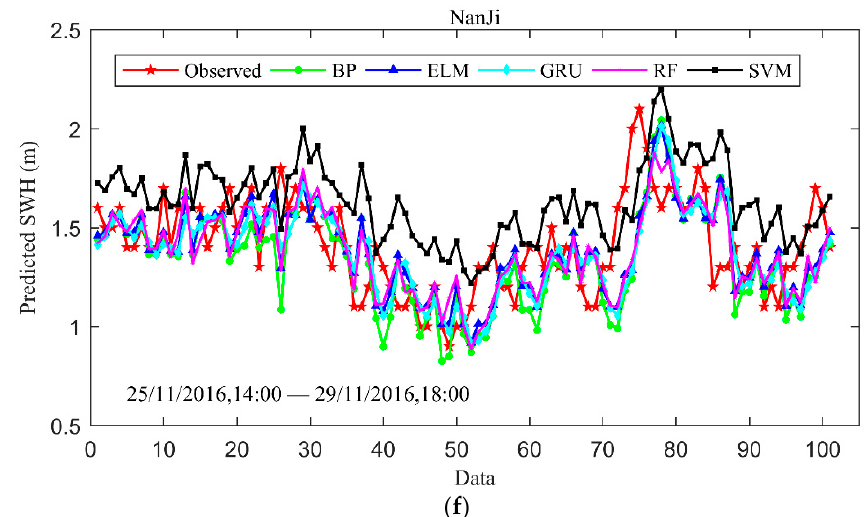
Figure 4. Comparison of five algorithms with lead times of 3 h at various stations: ( a ) station 46714D, ( b ) station 46735A, ( c ) station 46787A, ( d ) station C6V27, ( e ) station C6W08, ( f ) station NanJi.